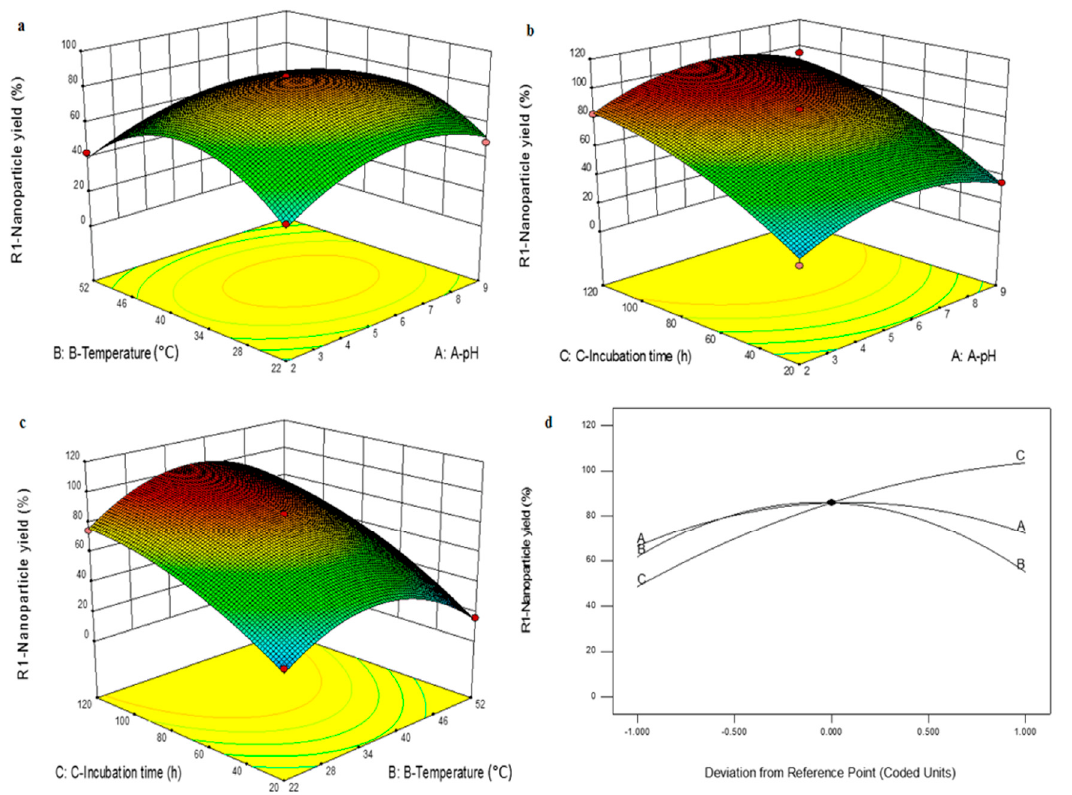
Figure 3. The 3D response surface plots showing the effects of interactions ( a ) effect of pH on Cr(VI) removal; ( b ) effect of temperature on removal of Cr(VI); ( c ) incubation time or contact time on Cr(VI) removal and ( d ) deviation from reference point (coded units). Note: A: effect of pH; B: effect of temperature; C: incubation time (min).